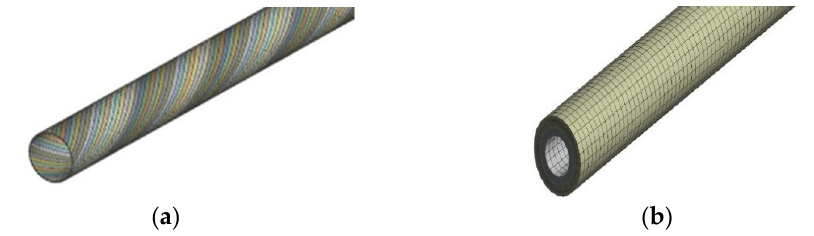
Figure 4. Mesh of flexible riser model. ( a ) Tensile armor layer, ( b ) Overall model